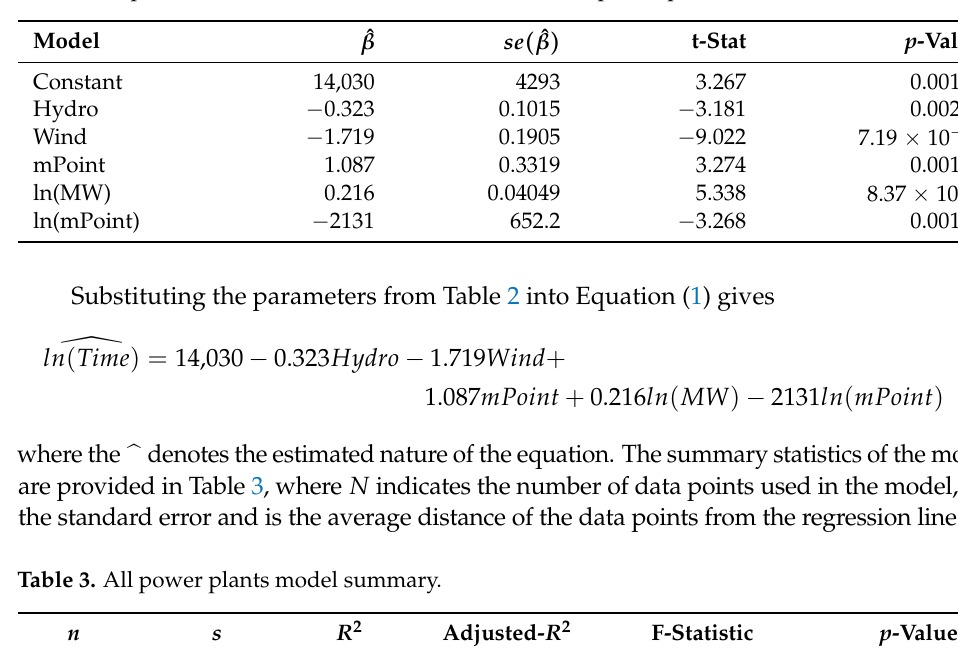
Table 2. Dependent variable: ln(Time)—coefficients for all power plants.